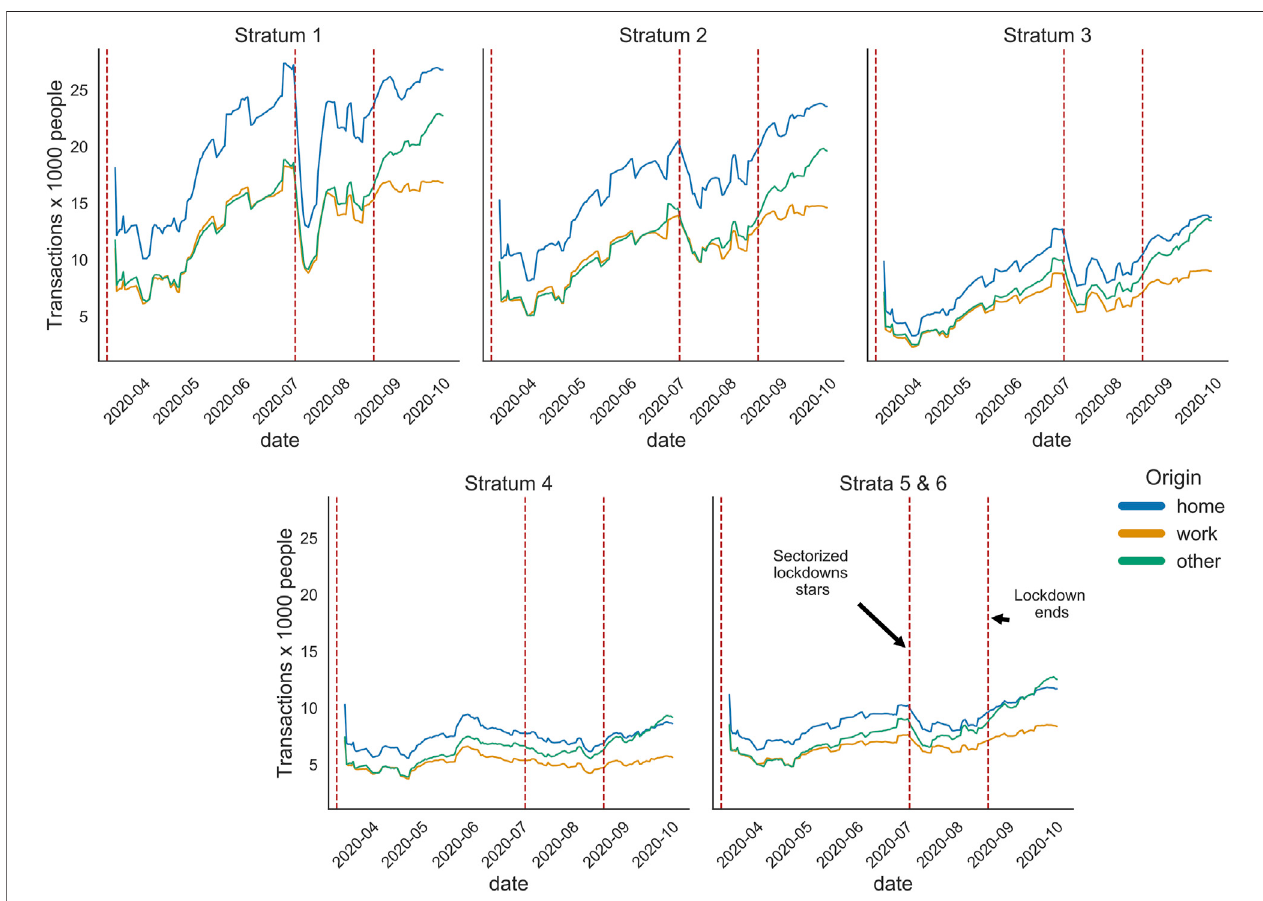
FIGURE6| Transactionsperthousandpeoplebystrataandlocationtypeintherecoveryperiodonly.Reddottedlinesmarkthestartofthelockdown(Mar/20),the sectorized lockdown (Jul/13) and the end of the lockdown (Sep/01).